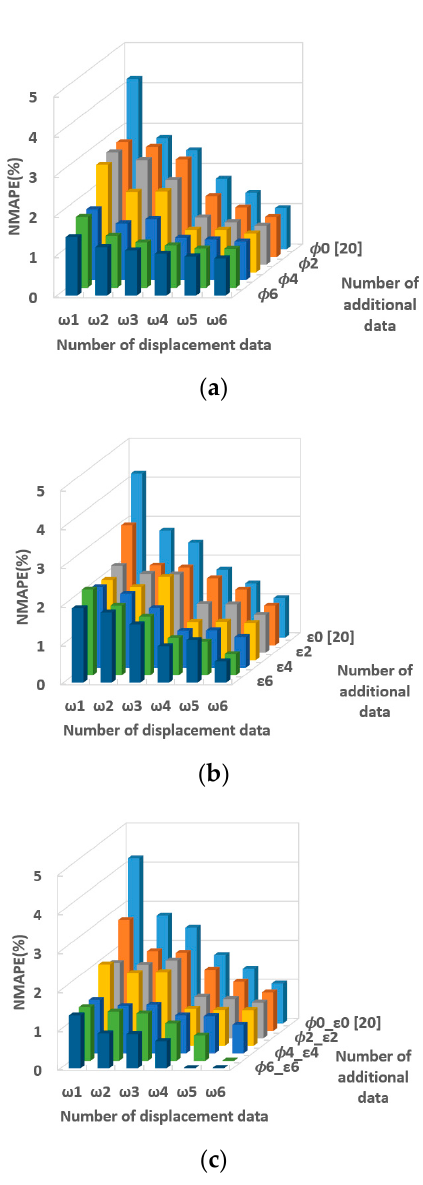
Figure 28. NMAPE according to the number and combination of sensors (RDS3): ( a ) displacement + slope; ( b ) displacement + strain; ( c ) displacement + slope + strain.